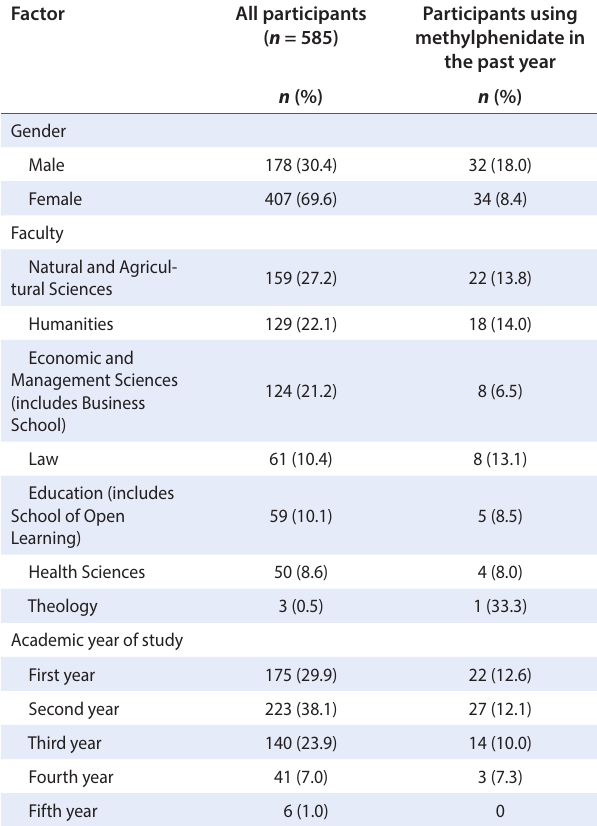
Table 1: Demographic description of participants and past year use of methylphenidate in demographic subgroups